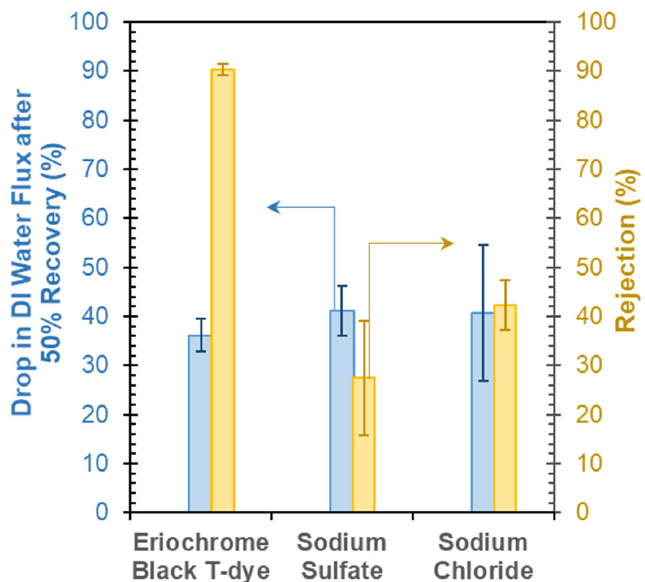
Figure 11. Comparison of dye ‐ and salt ‐ rejection performance and influence of 50% water recovery on DI water flux of 2 ‐ bilayer GO–PEI ‐ modified CA membrane. on DI water flux of 2-bilayer GO–PEI-modified CA